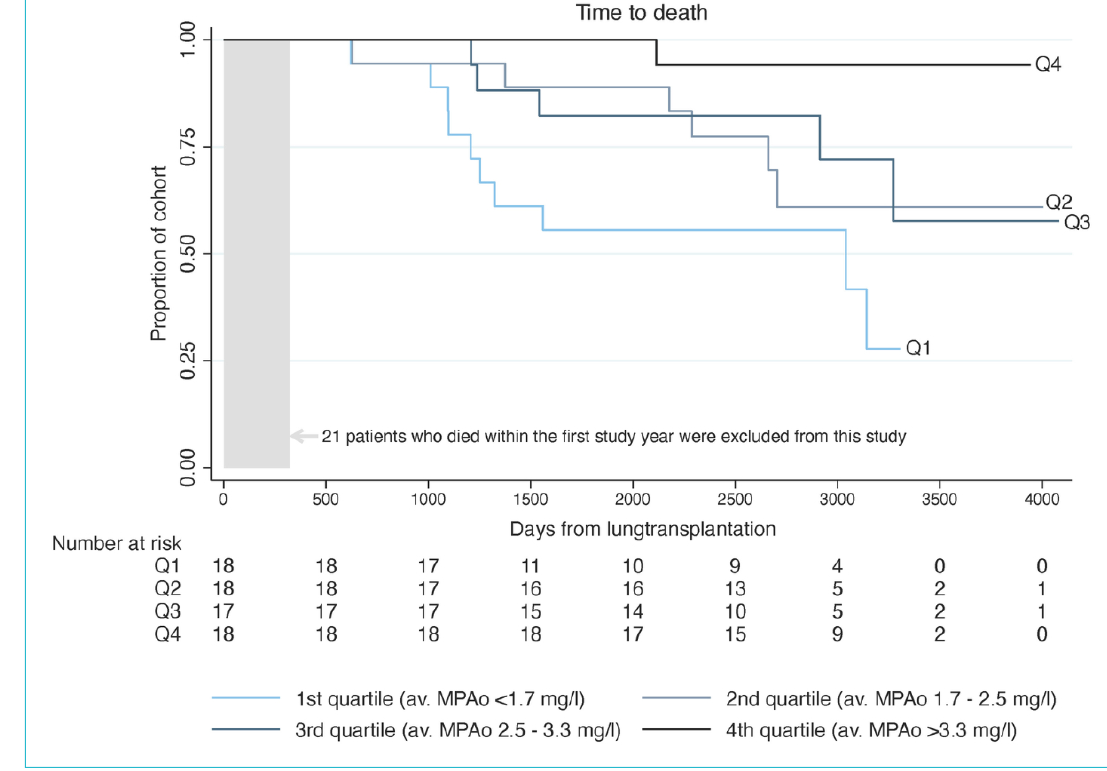
Figure 3: Kaplan-Meier graph survival estimate Q. In the first 4 post-transplant years (i.e., 1461 days) cumulative death-rate was 25%. A total of 50% of the patients died by the ninth post-transplant year (i.e., 3287 days). Patients who died within the first year were excluded from this